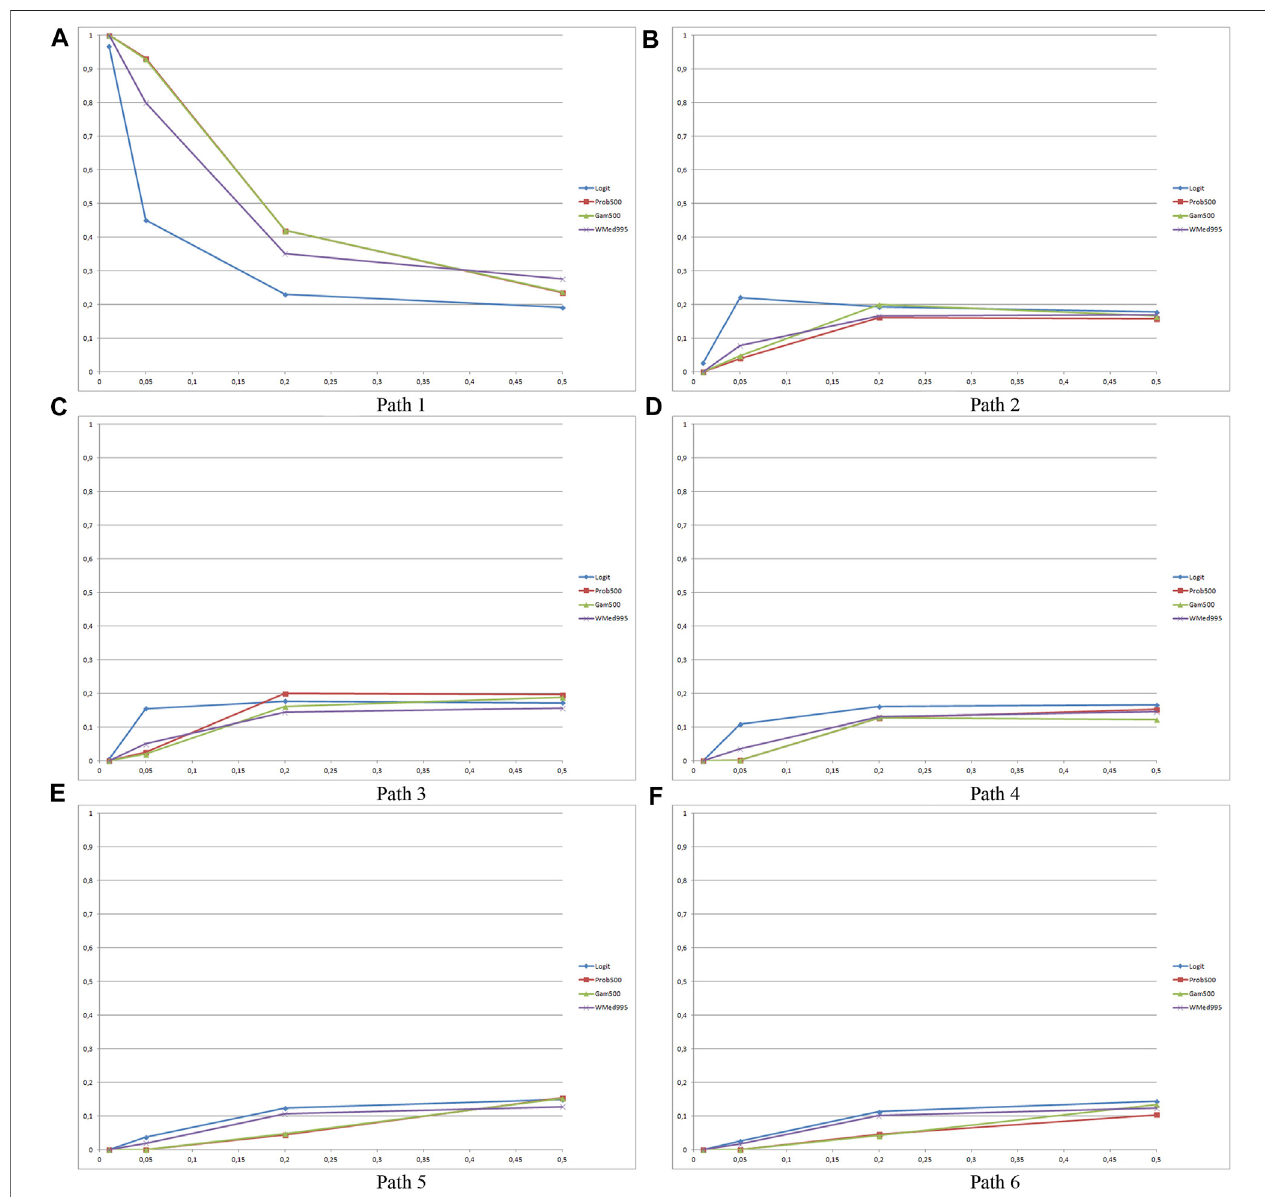
FIGURE 5 | Path choice probabilities depending on Cv for each path: Logit vs. Weibit, Probit, and Gammit best models.